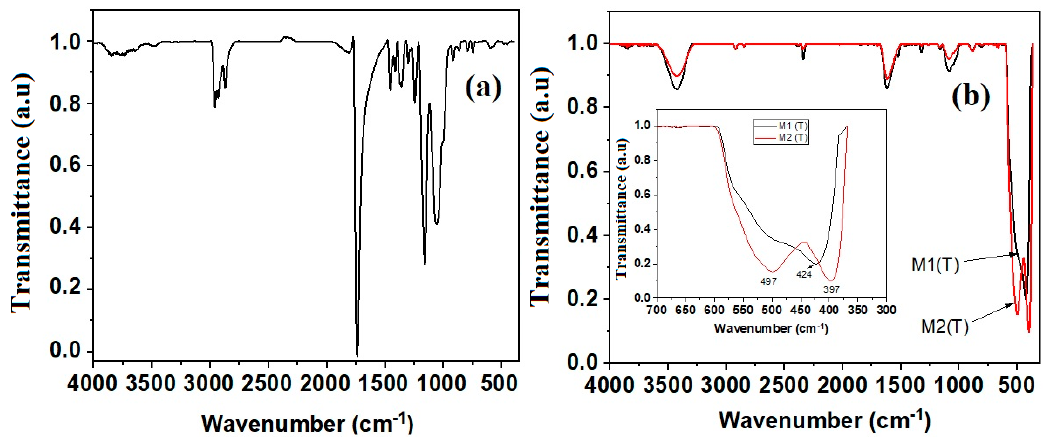
Figure 2. Fourier transform infrared (FTIR) spectra of CAB nanofibres ( a ) and carbon / ZnO; ( b ) for the two types of nanostructures M1 (T) and M2 (T) , respectively.